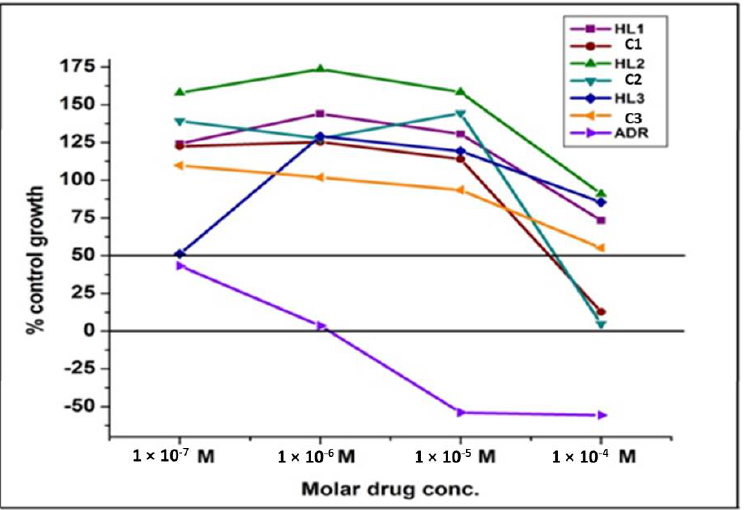
HL 3 ) and their Ni(II) complexes (C 1 – C 3 ) is represented in Figure 4. All the synthesized